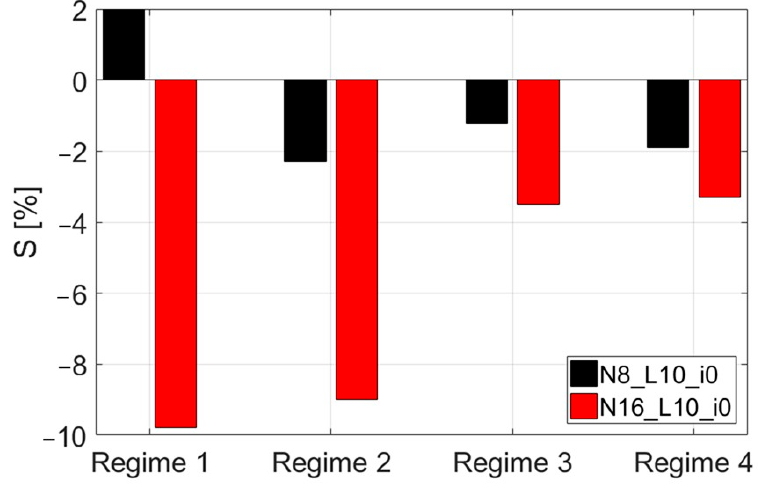
Figure 9. Variation of the specific fuel consumption depending on the regime and nozzle type.